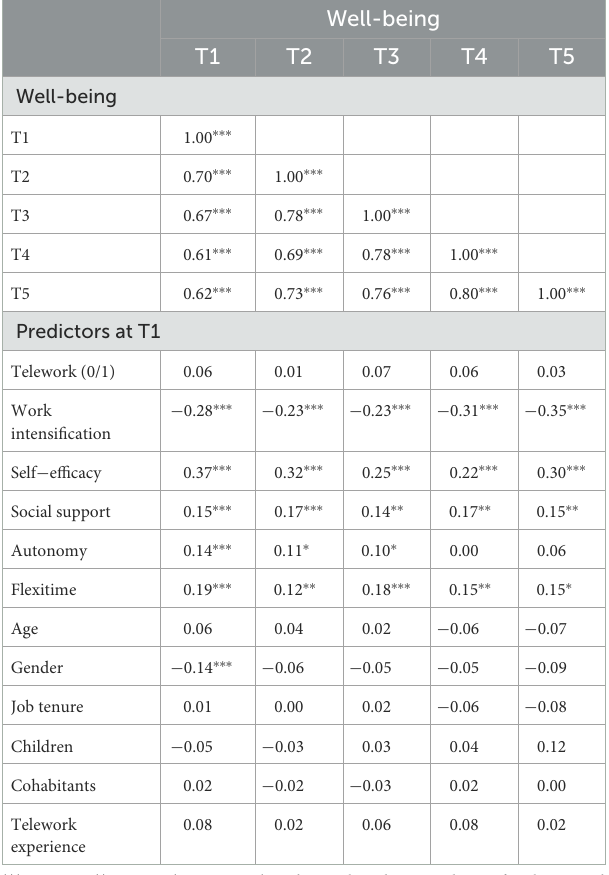
Table A1 Correlations among study variables and well-being at different time points.